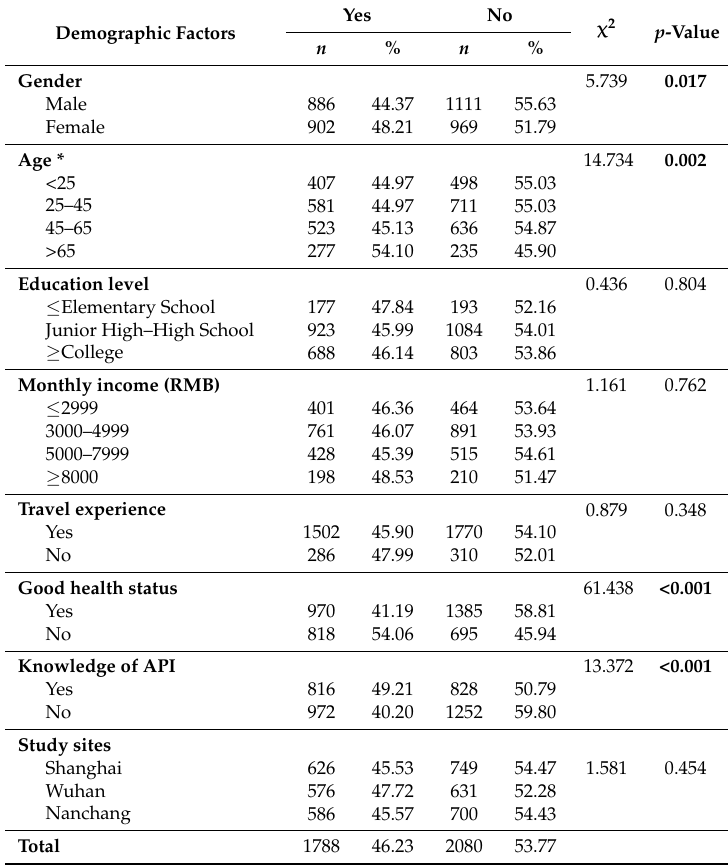
Table 4. Respondents’ feelings of anxiety when exposed to contaminated